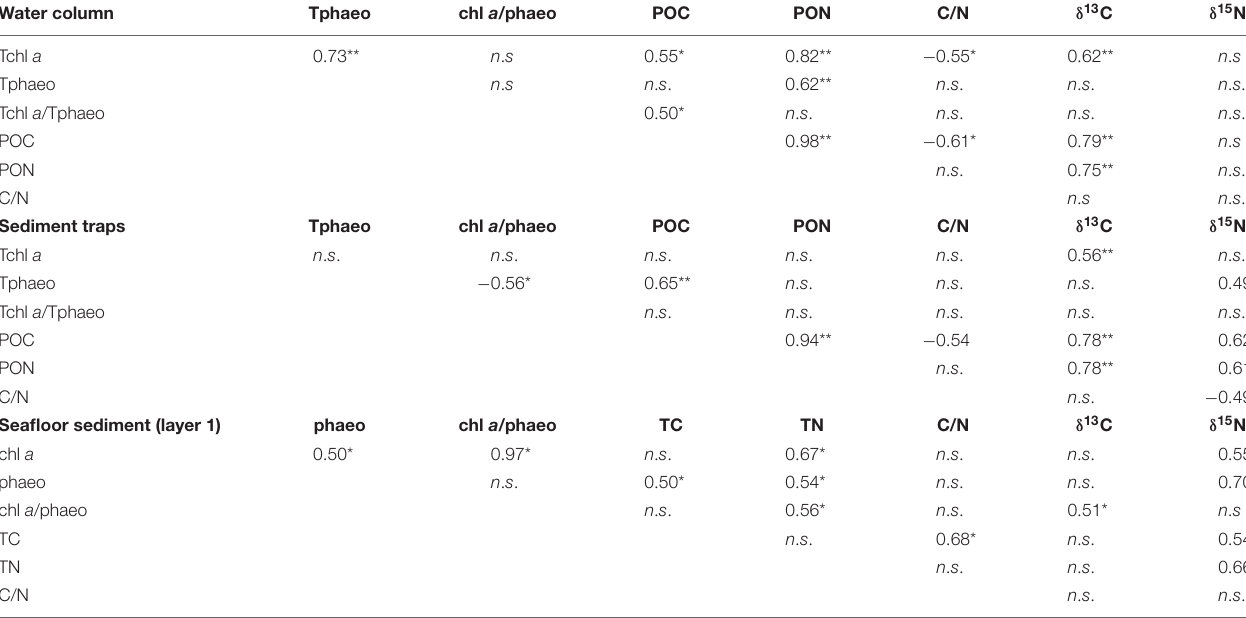
TABLE 3 | Correlations (R) between the different organic compounds within the same sampling compartment (i.e., water column, sediment traps, and seafloor sediment surface). Water column Tphaeo chl a